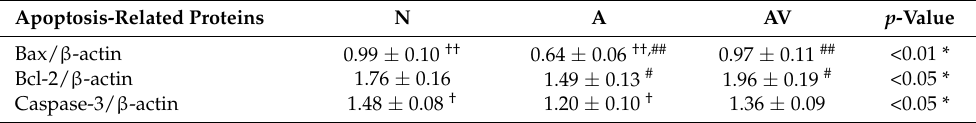
Table 5. Apoptosis-related proteins in ApoE4-KI mice after auditory and audiovisual stimulation. Apoptosis-Related